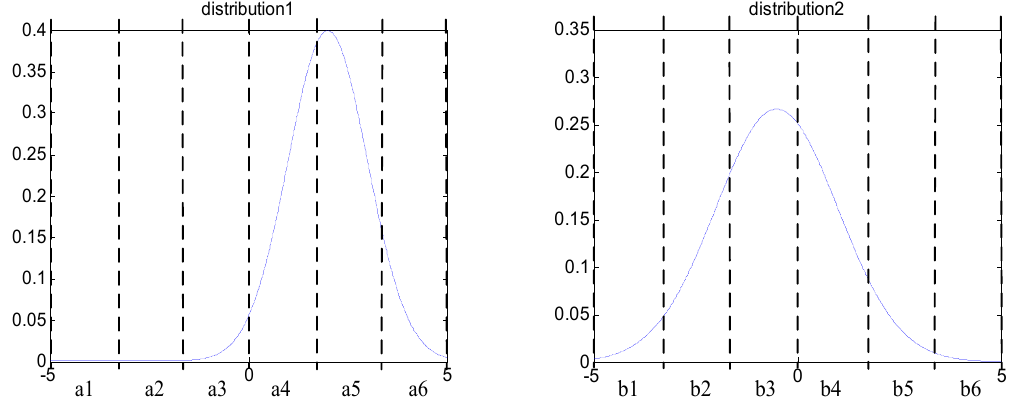
Figure 6. Probability density distribution of important points.